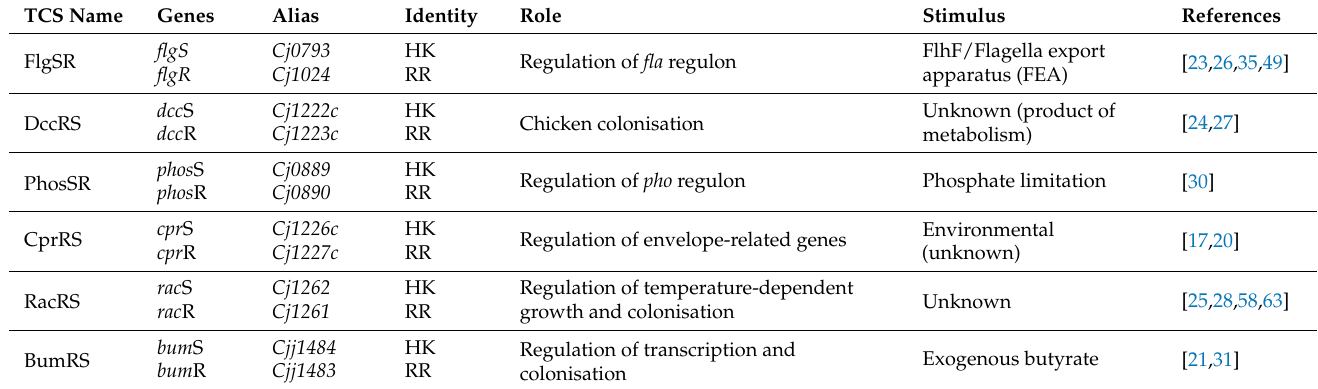
Table 1. TCS of Campylobacter jejuni